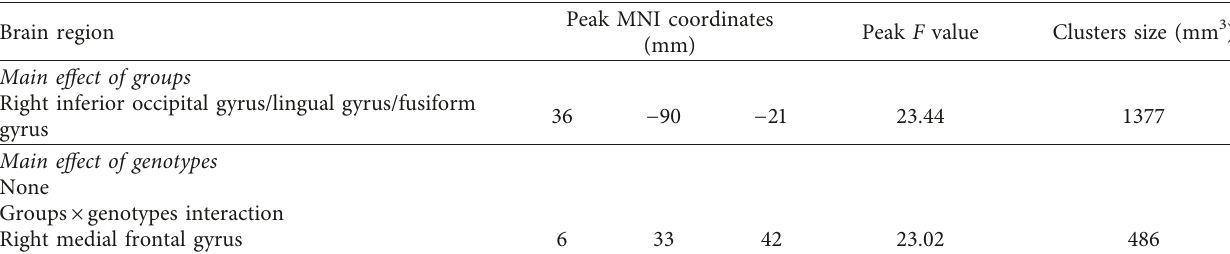
Table 3: Groups × genes ANOVA of